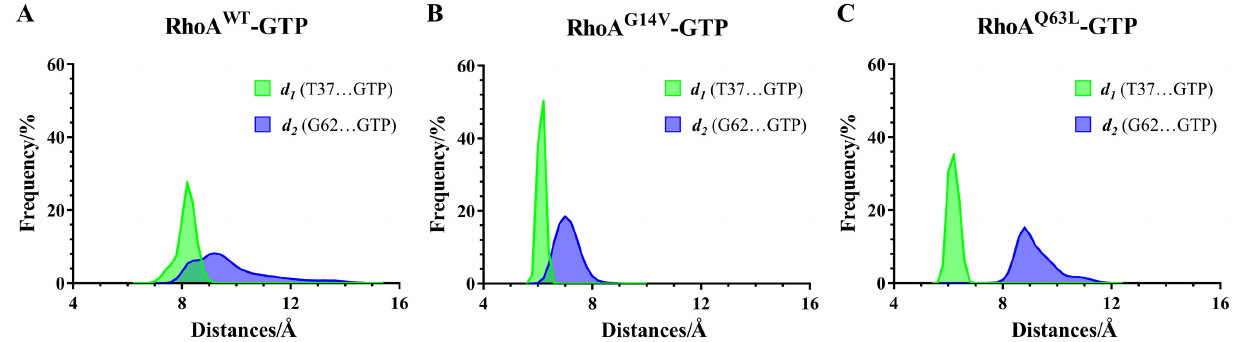
Figure 4. The probability distributions of two atom ‐ pair distances, d 1 and d 2 , were calculated on the snapshots obtained from the triple independent runs of the complexes of RhoA WT ‐ GTP ( A ), RhoA G14V ‐ GTP ( B ), and RhoA Q63L ‐ GTP ( C ).